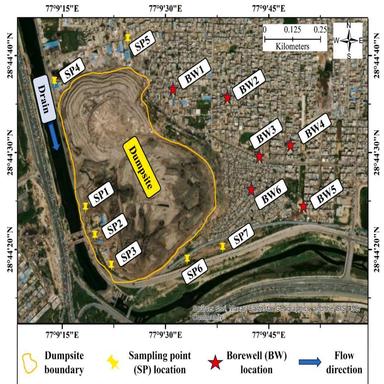
Site location highlighting dumpsite boundary, sampling point (SP), borewell (BW) locations and flow of Drain.